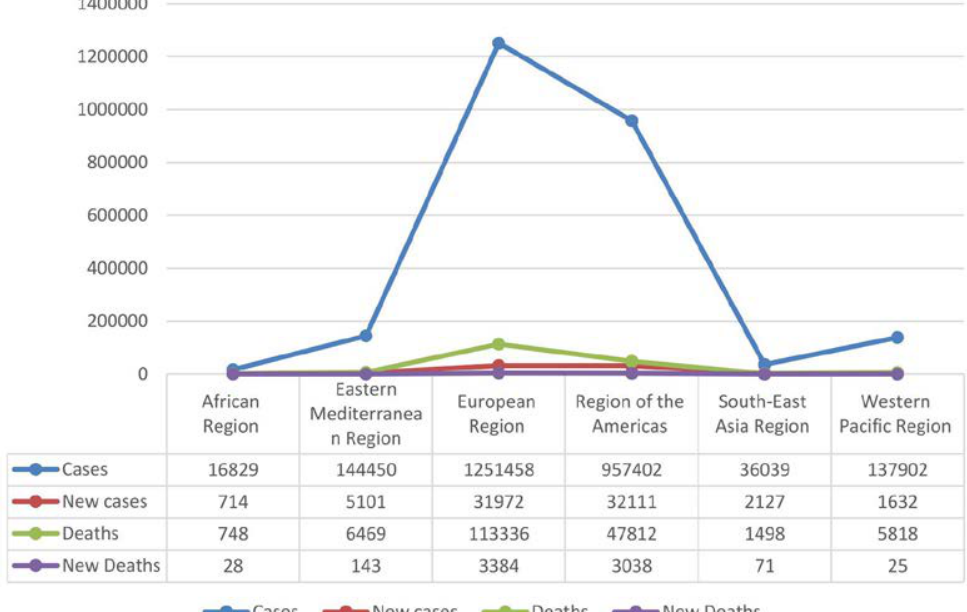
Fig. 2. Continental based cases of COVID-19 98674 cases with 2.4% mortality, Iran 85,996 cases with 6.2% mortality and China 82,631 cases wit 4.0% mortality as shown in Fig. 3 & 4.